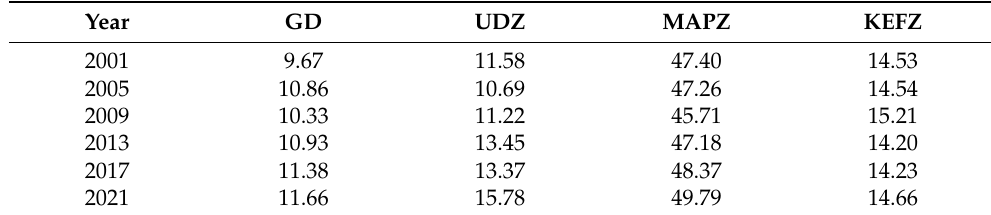
Table 6. Deviations in GDP and carbon emissions gravity center (km) across Guangdong Province and its MFOZs from 2001 to